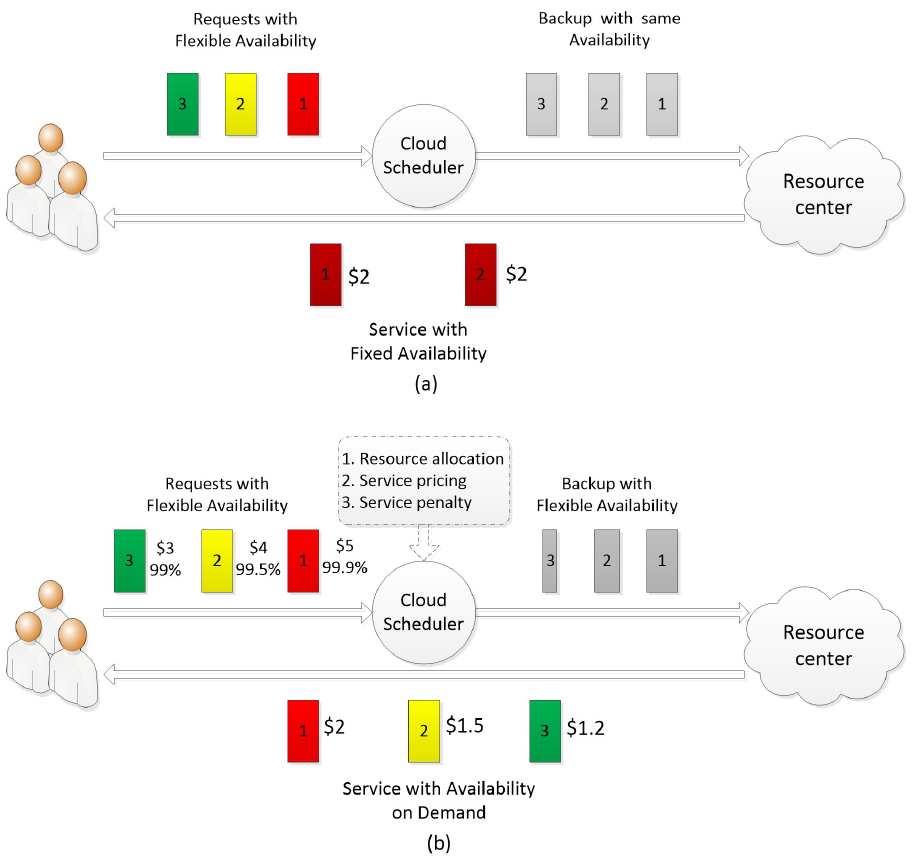
Figure 2. Illustration of two resource allocation approaches: ( a ) allocation with fixed availability and price; ( b ) allocation according to different availability demands and valuation of users with different price. Different colors represent different availability, and different sizes of grey blocks represent a different backup